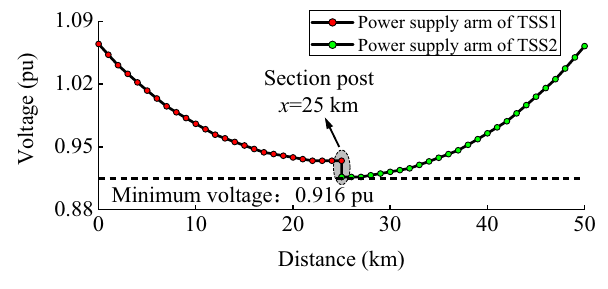
Fig. 18 Voltage distribution of AC 27.5 kV system at closely running